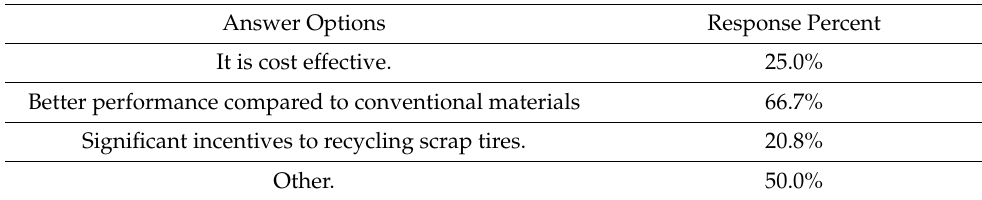
Table 10. Reasons for using GTR in